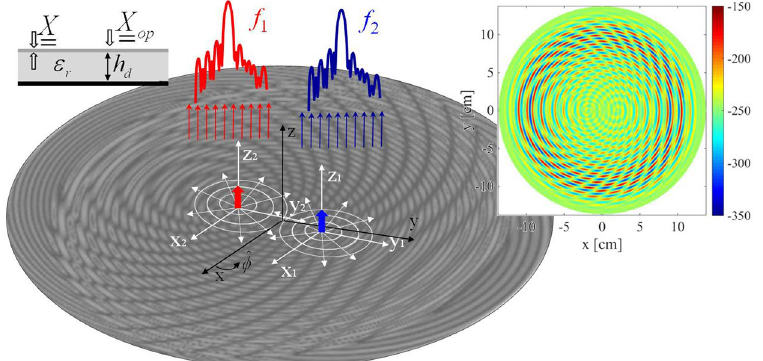
Figure 9. Layout and feeding positioning of the proposed dual band antenna. Position of the feeders are highlighted with the local coordinate systems; each feed is associated to a different frequency. The interference of the two modulation functions is shown in the inset on the upper right inset.